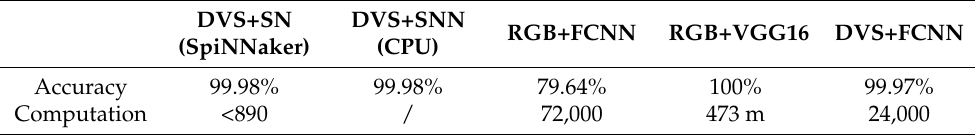
Table 2. Comparison of the SNN/ANNs on the DVS-based/RGB datasets.